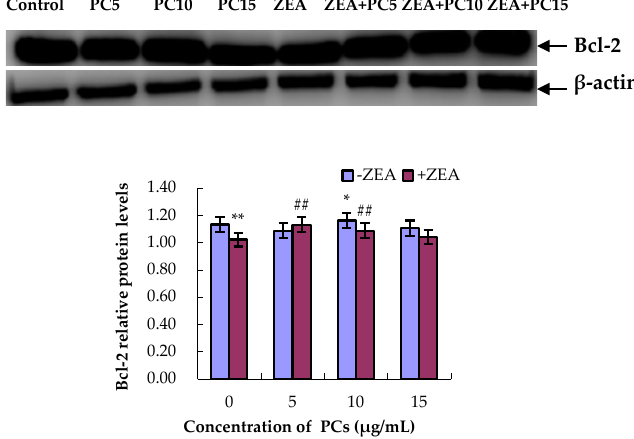
Figure 10. Effects of different concentrations of proanthocyanidins (PCs) on zearalenone (ZEA)-induced relative expression of Bcl-2 protein in MODE-K cells. The relative expression of Bcl-2 protein decreased when cells were exposed to ZEA, while the expression did not decrease when cells were treated with PCs. The expression increased when cells were co-treated with PCs/ZEA. * p < 0.05 and ** p < 0.01 vs. control group; ## p < 0.01 vs. ZEA-treated group.